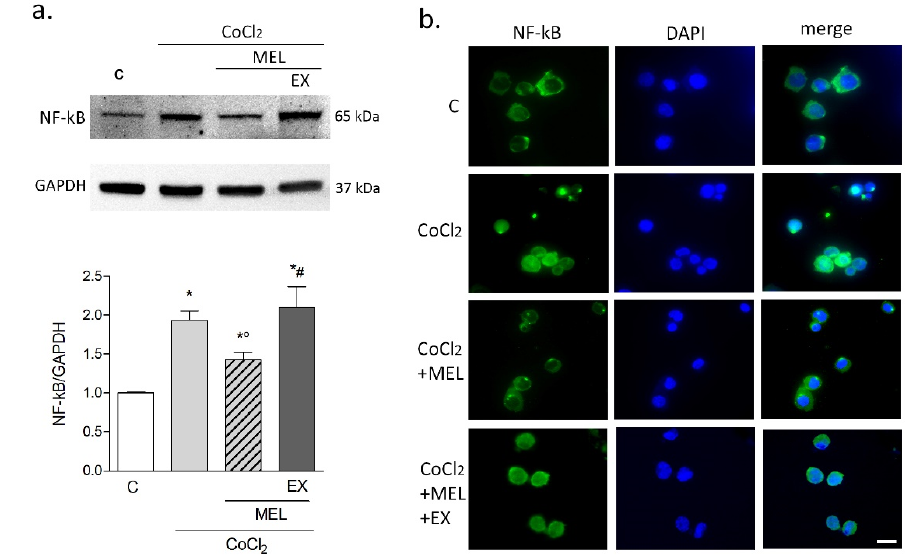
Figure 6. Melatonin attenuates NF-kBp65 upregulation by CoCl 2 in microglia. Western blot analysis ( a ) of NF-kBp65 levels in BV2 cells exposed to CoCl 2 (250 μ M for 8 h) alone, or in combination with either melatonin (1 μ M) or melatonin + EX527 (5 μ M). In ( b ), immunostaining of NF-kBp65 (green) and nuclear counterstaining with DAPI (blue) following exposure to CoCl 2 alone (250 μ M for 8 h), or in the presence of melatonin (1 μ M) + EX527 (5 μ M). Bars are mean ± SEM of three independent experiments. * p < 0.05 vs. control (C), ° p < 0.05 vs. CoCl 2 and # p < 0.05 vs. CoCl 2 + MEL by one-way